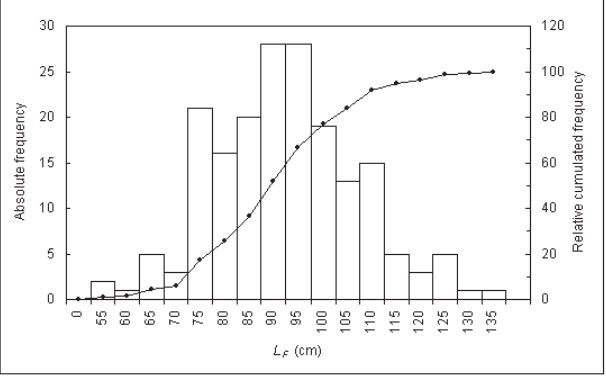
Fig. 4 . Size distribution of absolute frequency (columns) and relative cumulated frequency (line) for black grouper Mycteroperca bonaci caught in South area.